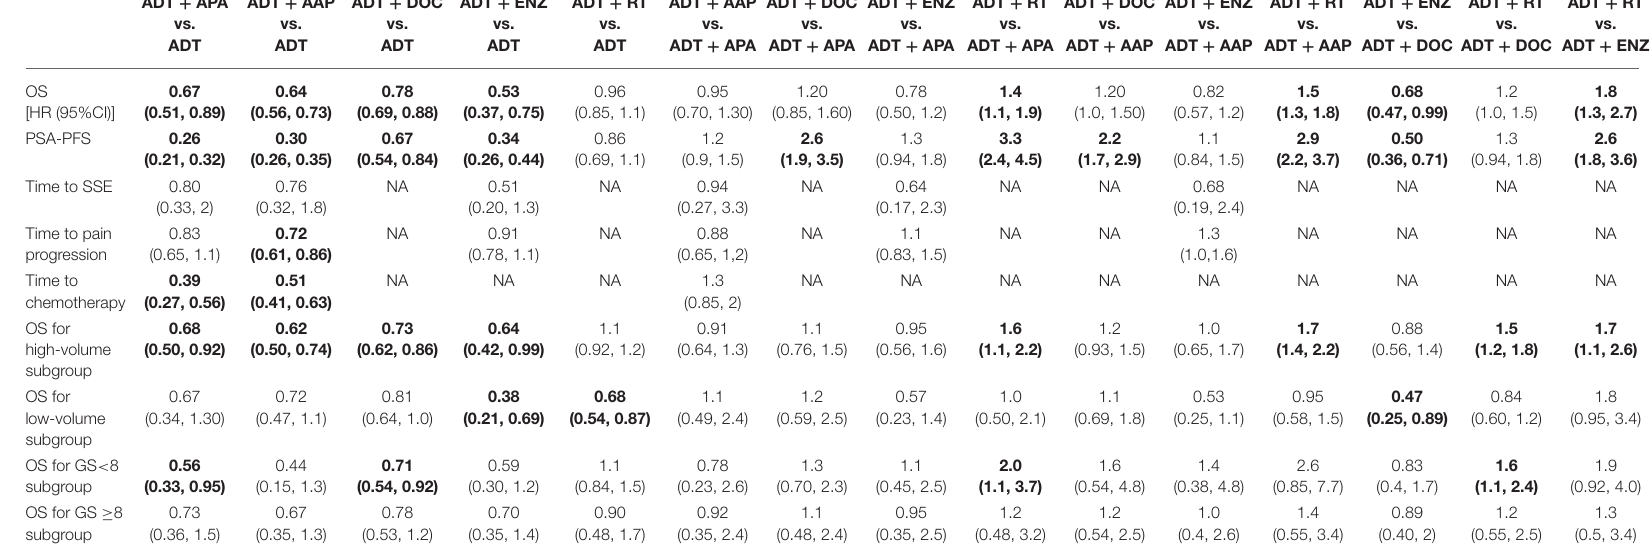
OS, Overall survival; HR, hazard ratio; 95%CI, 95% confidence intervals; PSA-PFS, prostate specific antigen progression-free survival; SSE, symptomatic skeletal events; GS, Gleason score; ADT, androgen deprivation therapy; APA, apalutamide; AAP, abiraterone and prednisolone; DOC, docetaxel; ENZ, enzalutamide; RT, radiotherapy; NA, not available. Comparison in bold refers to the statistically significant